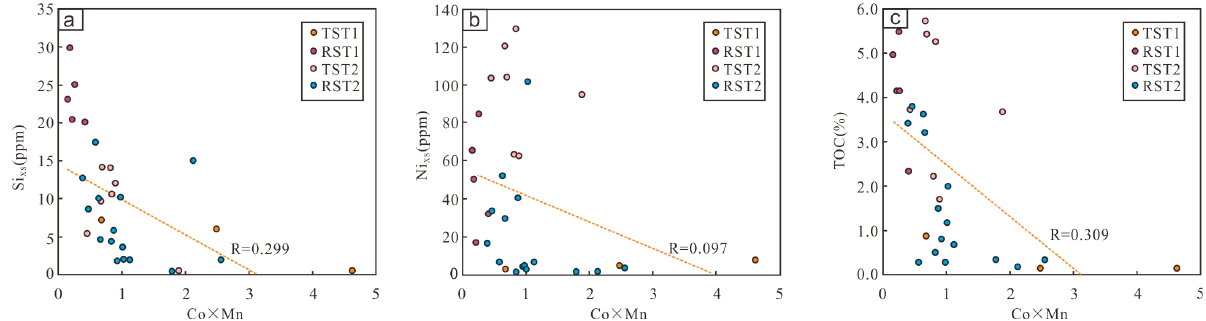
Figure 9. Crossplots of Co × Mn vs. ( a ) Si XS , ( b ) Ni XS , and ( c ) TOC of samples from Well SY1.